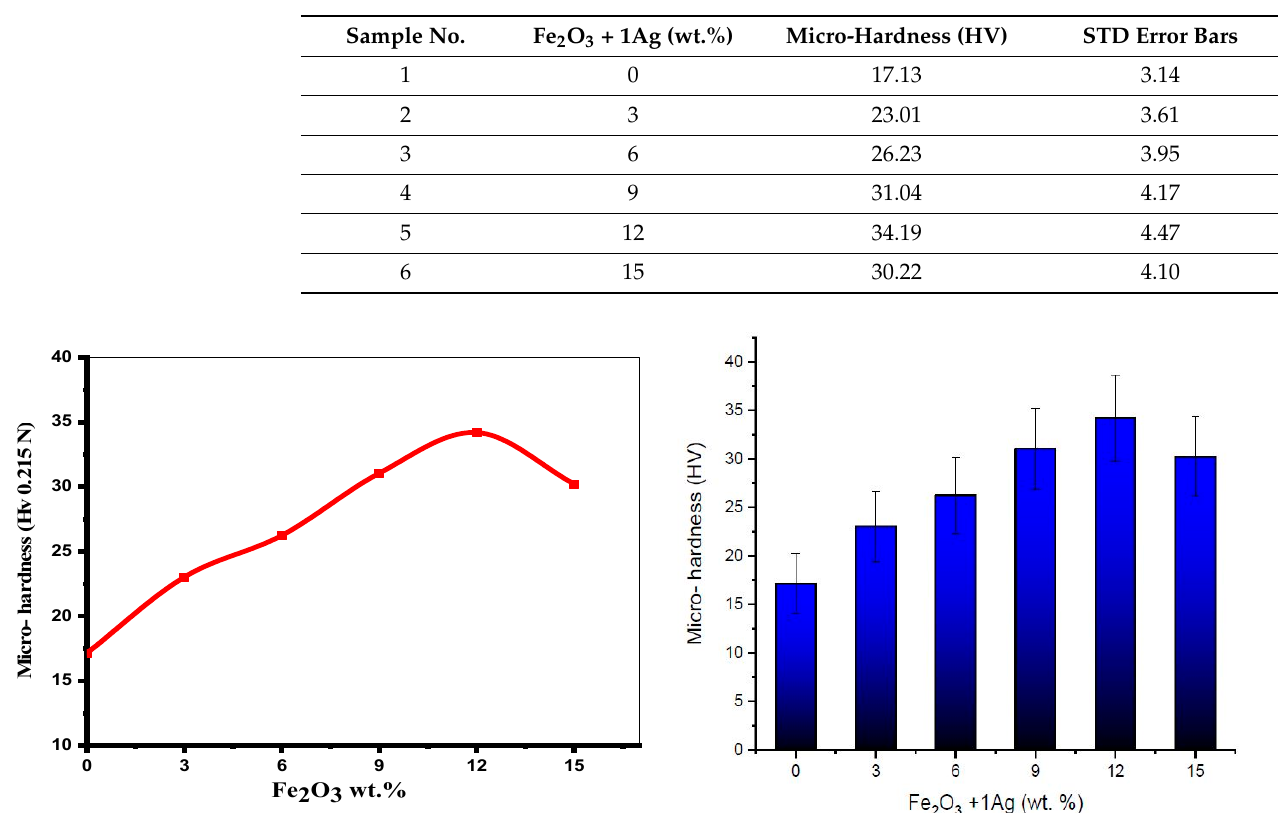
Figure 3. The variation of micro ‐ hardness with different wt.% of Fe 2 O 3 .